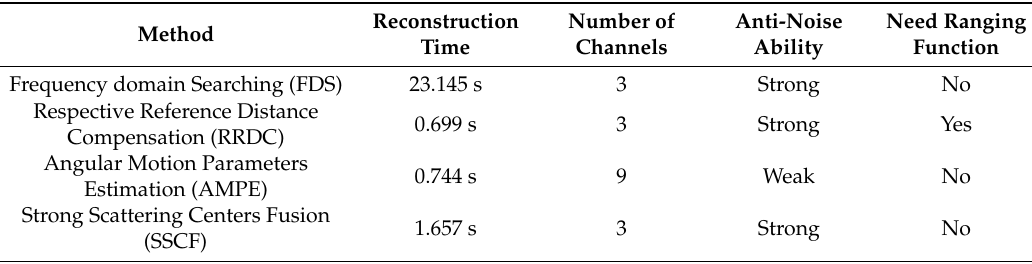
Table 2. Comparison of algorithm performances.